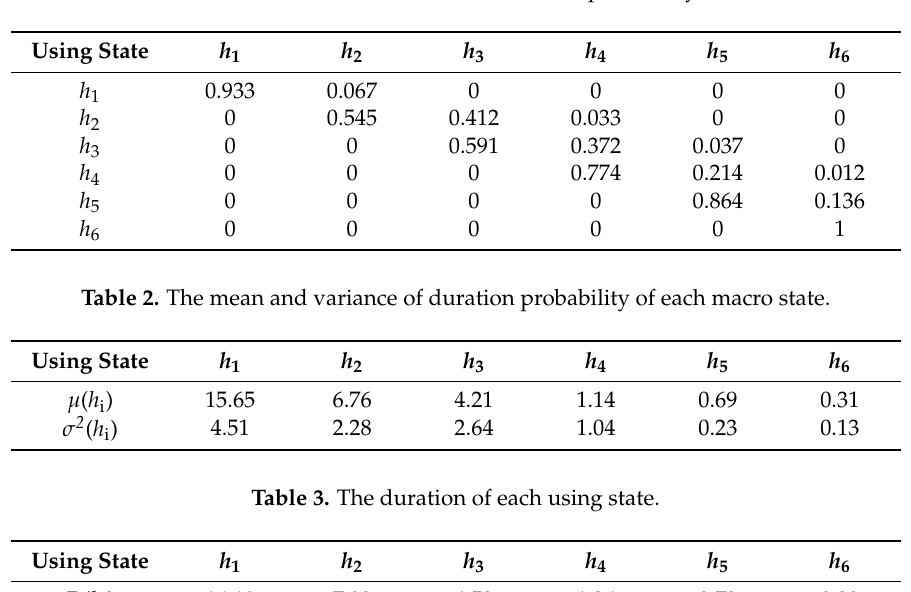
Table 1. The matrix of state transition probability.